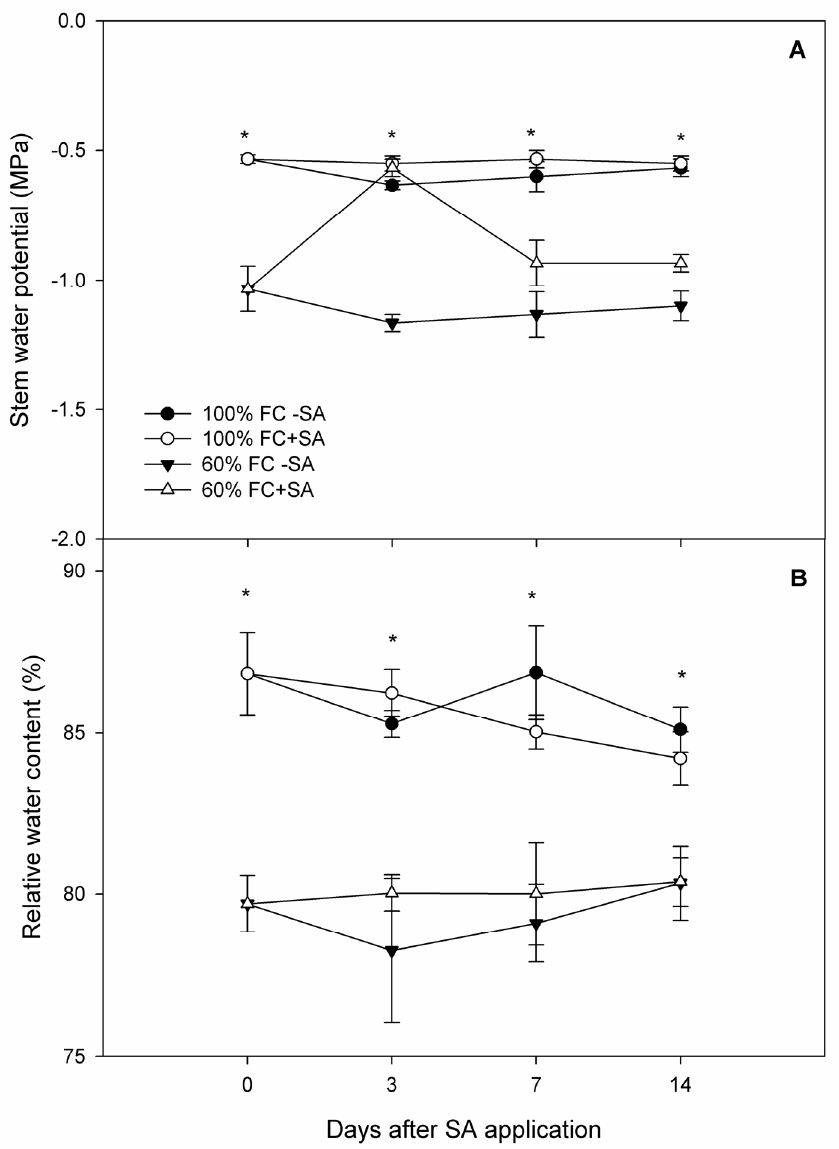
Figure 1. ( A ) Stem water potential and ( B ) relative water content in A. chilensis plants grown under 100% and 60% FC and two SA doses (0 and 0.5 mM) at different times post SA application. The bars are means ± SE ( n = 3). According to Tukey’s test, asterisks indicate significant differences between irrigation treatments of the experiment for the same SA treatment and time post SA application ( p ≤ 0.05).